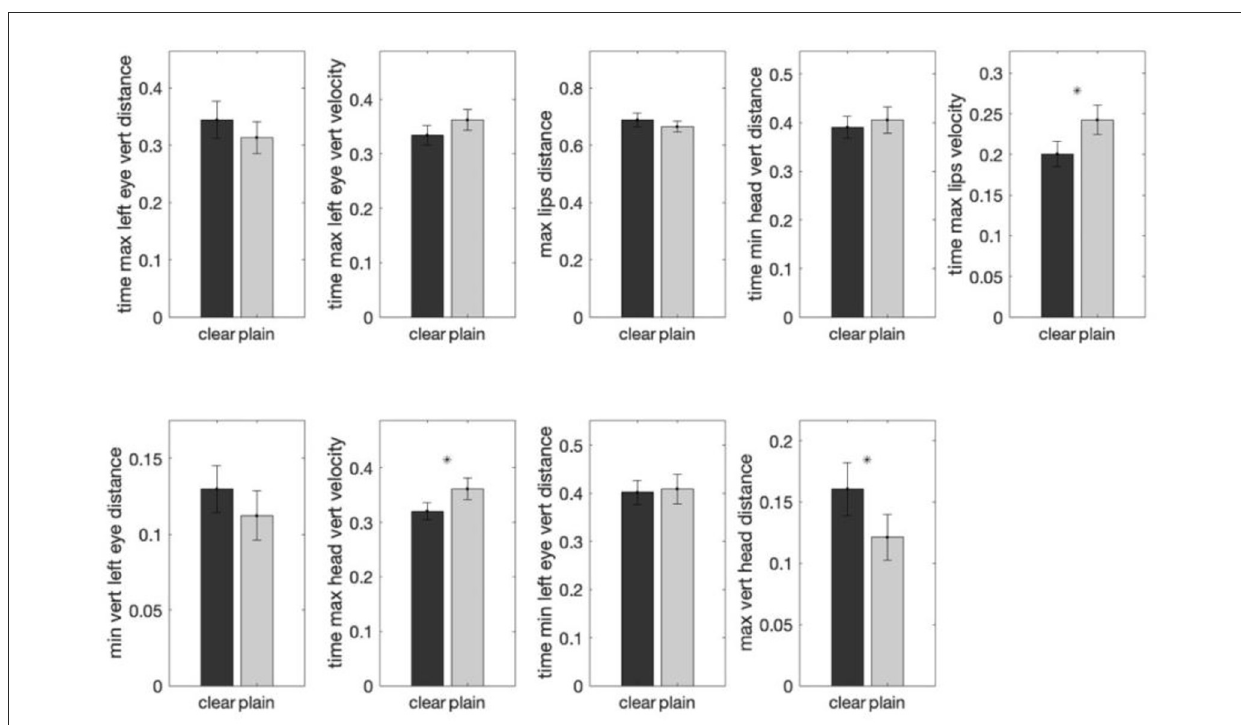
FIGURE9 Comparisons of the group means of each of the nine important features (determined by random forest analyses) in clear and plain style in Tone 3. The y-axis shows the average normalized feature value for that particular style group. Three features were found to exhibit a statistically significant difference between the two speech styles by mixed-effects modeling. The error bar on each of the bar plots shows the standard error. A * above a bar represents a p-value smaller than